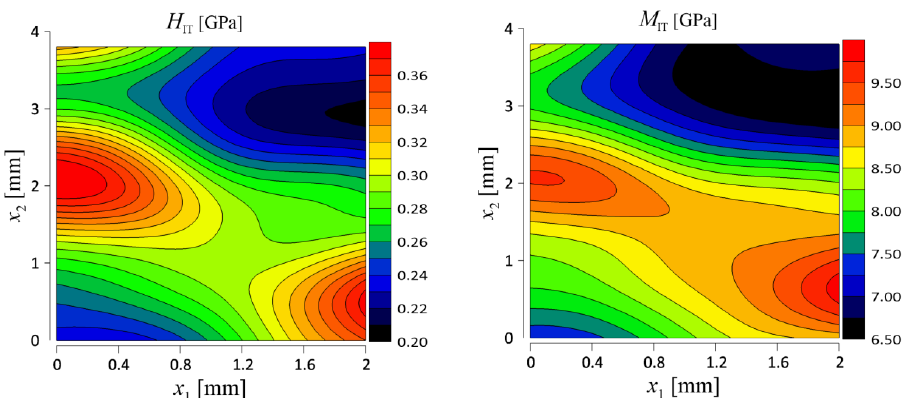
Figure 11. Distribution of hardness and indentation modulus for Board B.